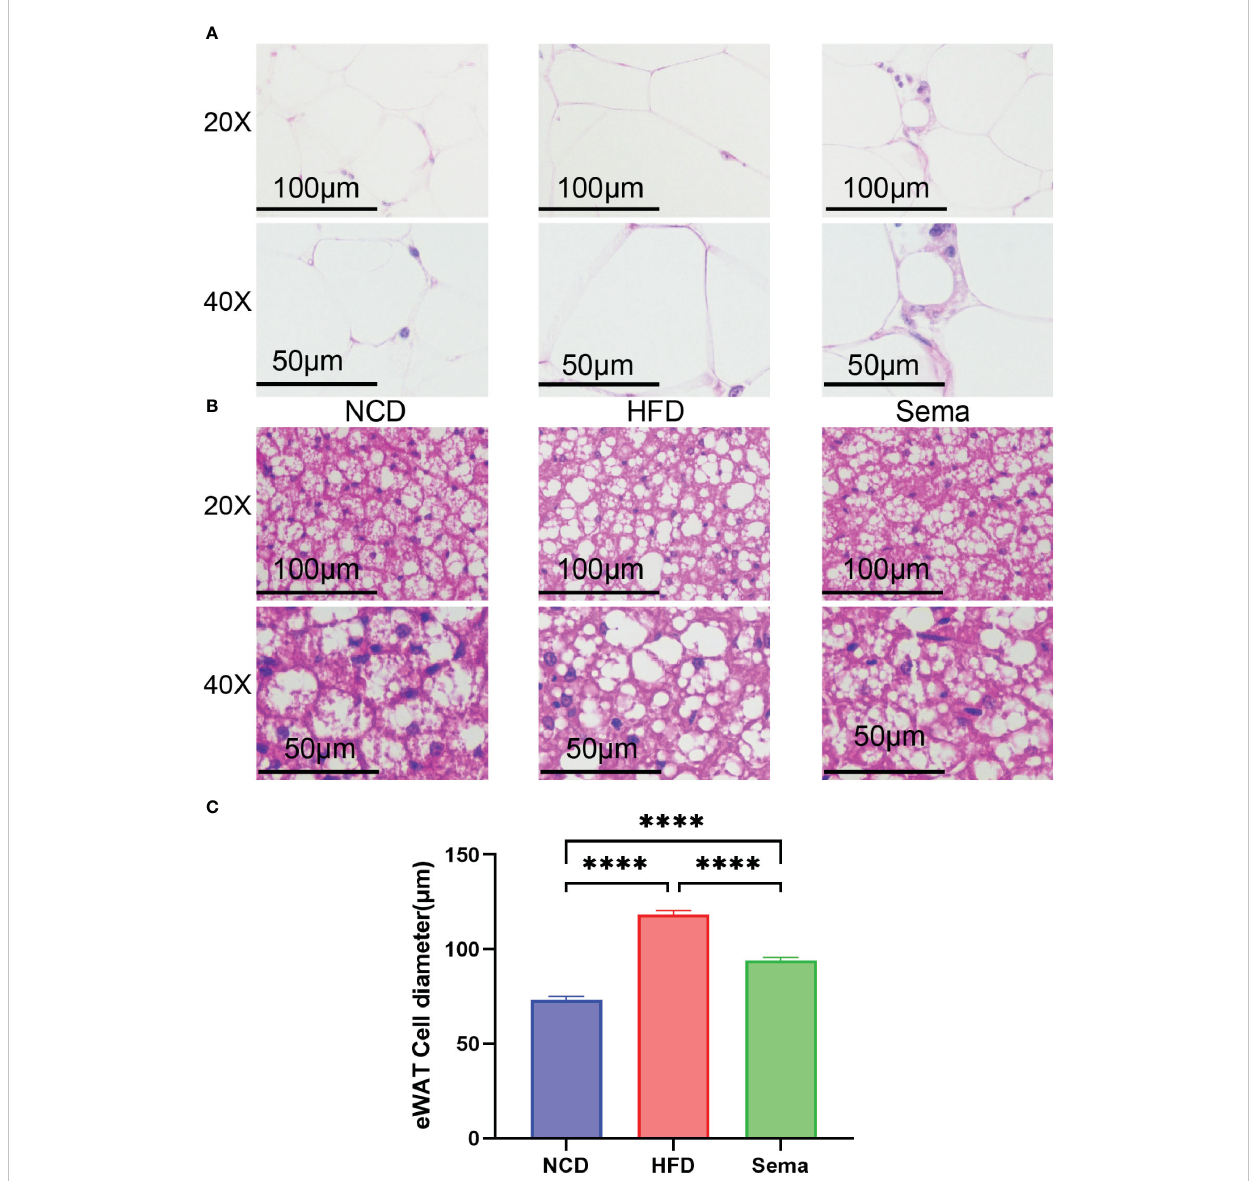
FIGURE 3 Representative image of histological changes of eWAT and iBAT. The size of adipocyte evaluated by staining with H&E. (A) Representative H&E staining from eWAT of mice. Scale bar, 100µm, and 50µm. (n=3). (B) Representative H&E staining from iBAT of mice. Scale bar, 100µm, and 50µm. (n=3). (C) The fat diameter of the adipocyte was quanti fi ed by Image J (n=5). Statistical results are presented as the mean ±SEM. ****p<0.0001 is an indicative signi fi cance compared with vehicle-treated right-side fat as